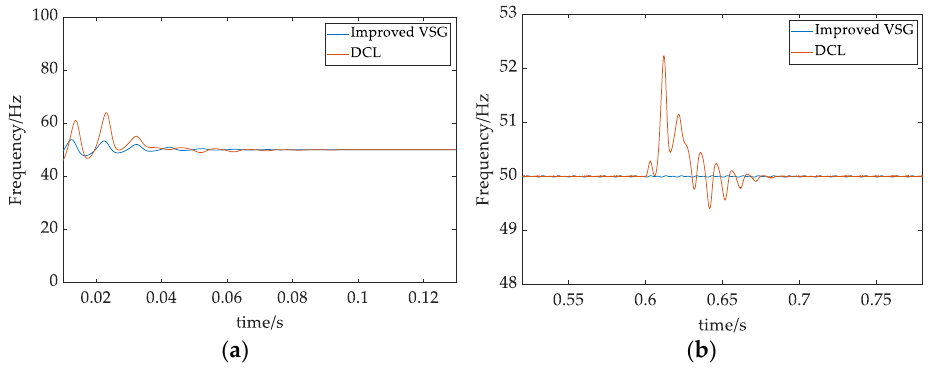
Figure 21. Output frequencies of MMC-RPC under two control methods of 15 MW load change. Partial diagram of output frequencies by setting: ( a ) MMC-RPC is put into operation, ( b ) sudden load change.